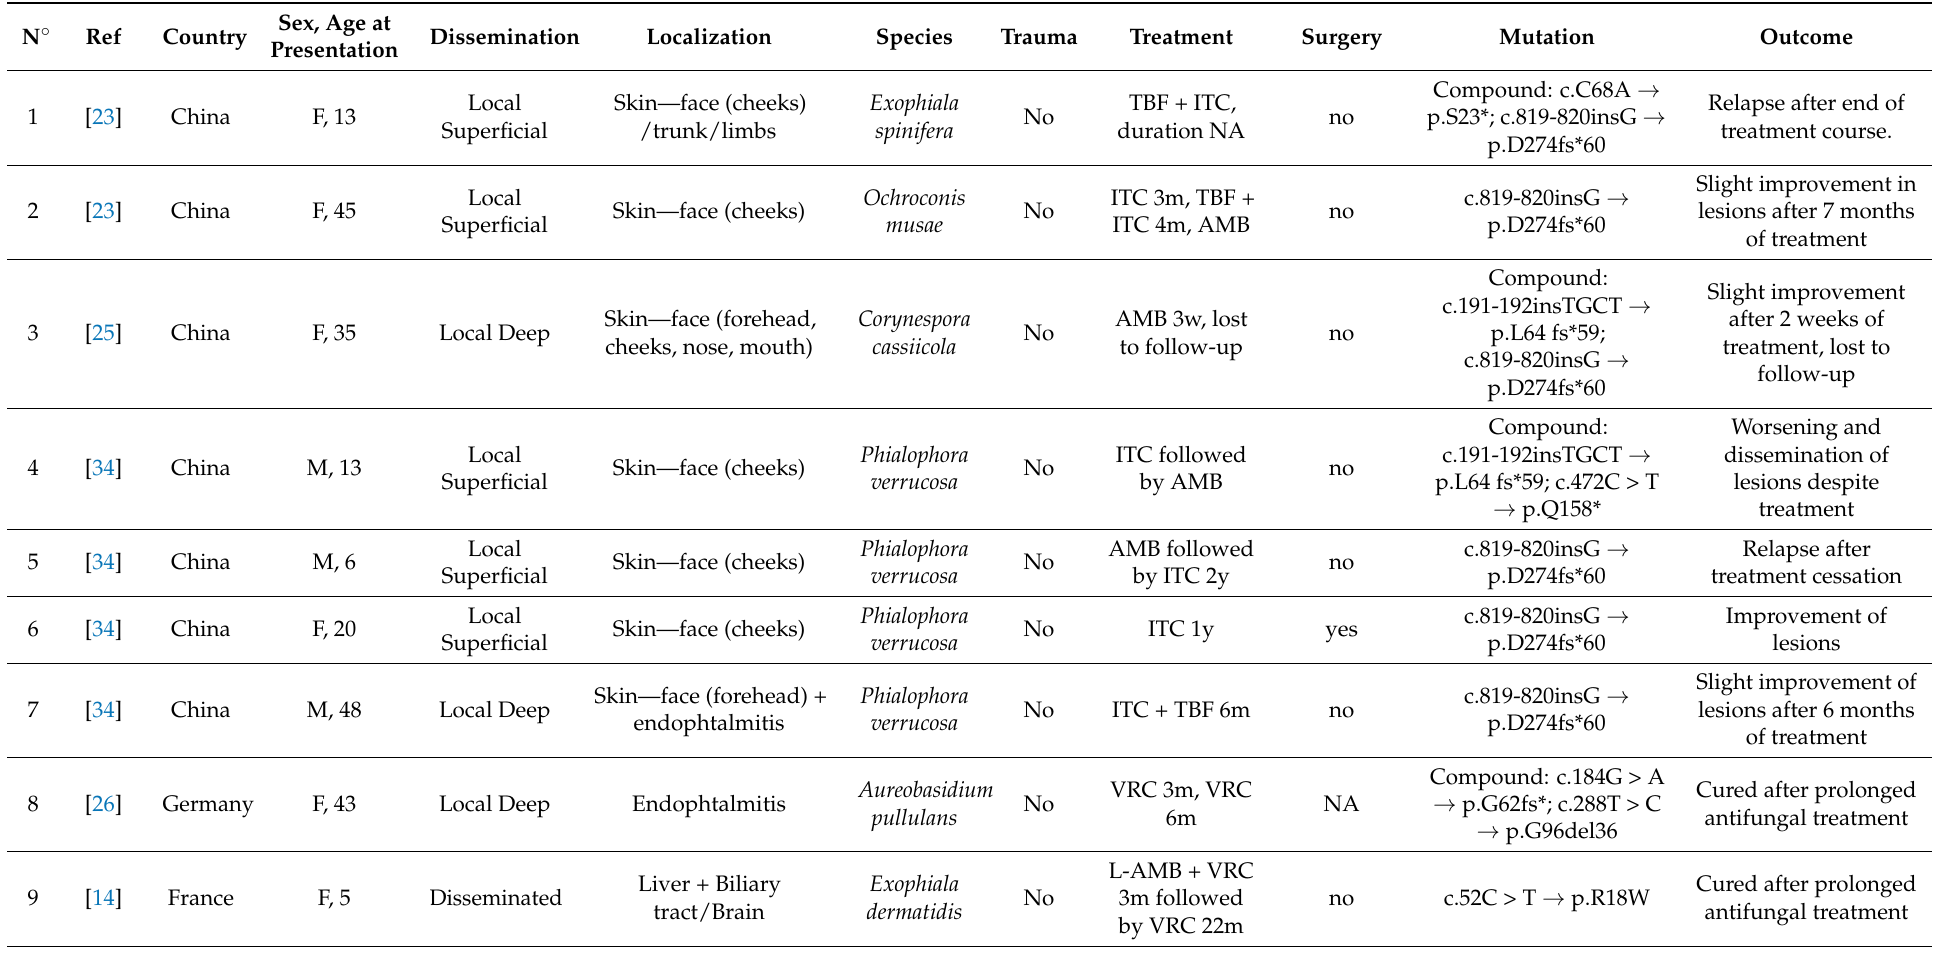
Table 1. Literature review of patients with phaeohyphomycosis in the setting of autosomal recessive CARD9 deficiency. 5FC, flucytosine; AmB, amphotericin B; CSP, caspofungin; ITC, itraconazole; F, female; GSV, griseofulvine; L-AmB, lyposomal amphotericin B; m, months; M, male; NA, not available; VRC, voriconazole; TBF, terbinafine; y,